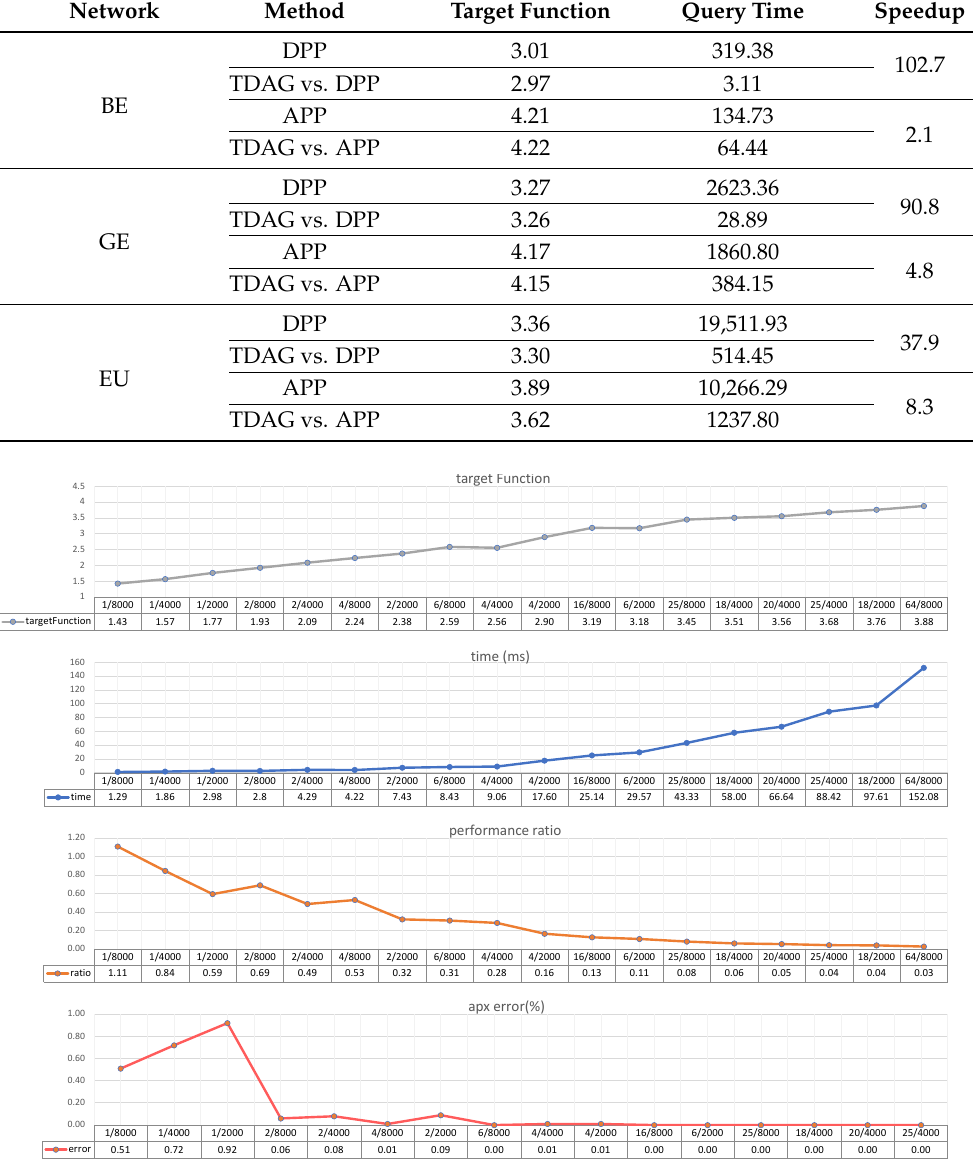
Figure 4. The targetFunction, execution time, and ratio of targetFunction/time of TDAG at GE. In the first row of the horizontal axis, the tested combinations of N / | L | are